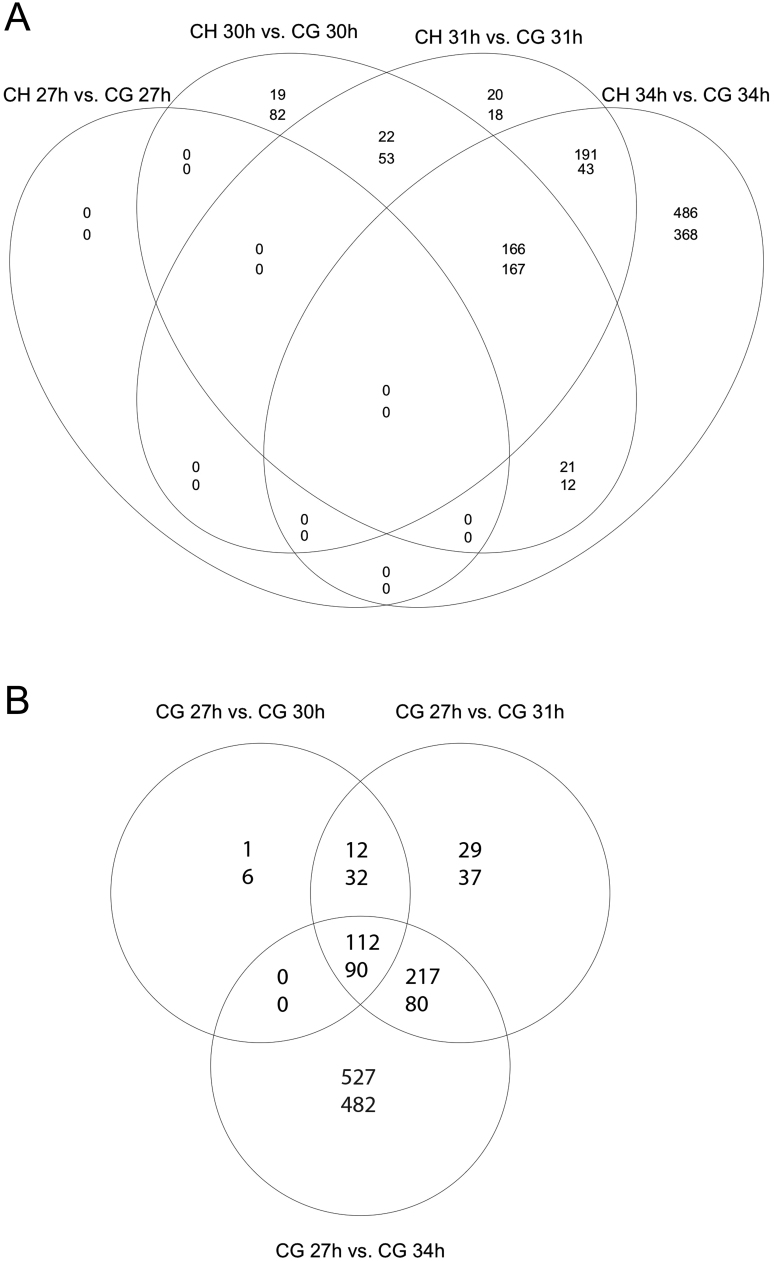
Global changes in gene expression in the chorionic girdle (CG) and adjacent chorion (CH) between days 27 and 34 of pregnancy. Venn diagrams showing the number of up (top number) and down (bottom number) regulated genes that changed in expression in the chorionic girdle compared day 27 chorionic girdle (A) and to the adjacent chorion (B).